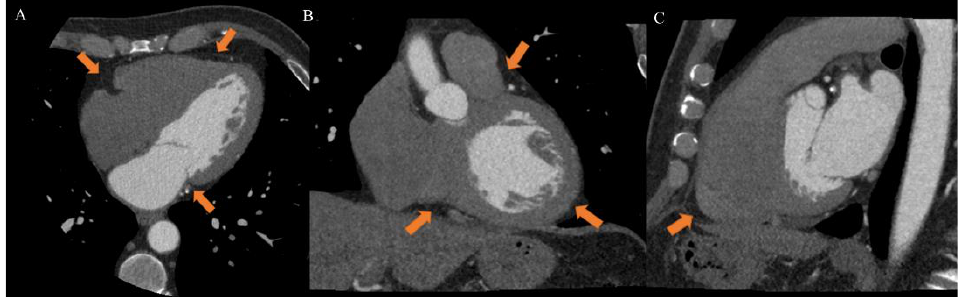
Figure 3. Case of a 46-year-old male patient underwent to cardiac computed tomography angiography